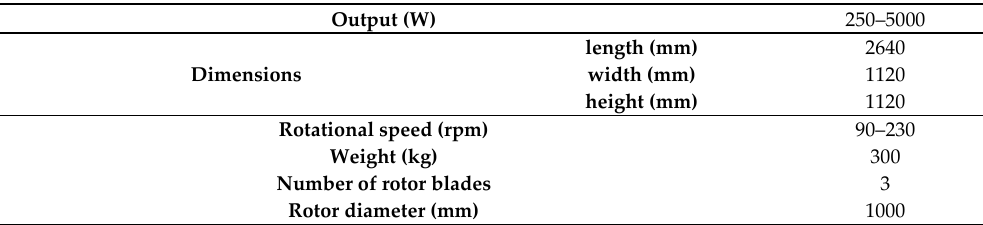
Table 2. Turbine specifications [6].